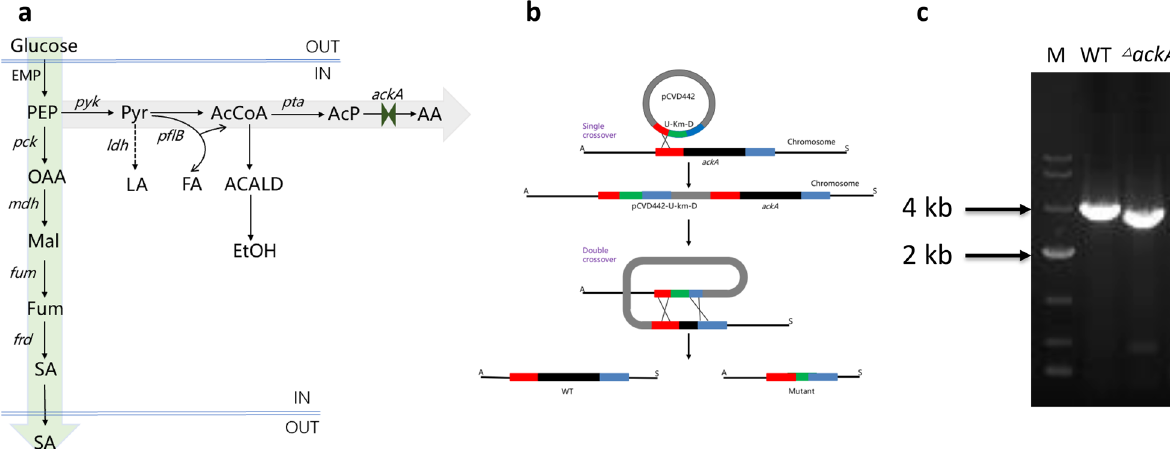
Fig. 1 The central metabolic network for SA biosynthesis in A. succinogenes ( a ) (PEP, Phosphoenolpyruvate; Pyr, Pyruvate; LA, lactic acid; AA, acetic acid; FA, formic acid; ACALD, acetaldehyde; EtOH, Ethanol; OAA, oxaloacetate; Mal, malate; Fum, fumarate; SA, succinic acid; AcCoA, acetyl-CoA; AcP, acetyl-phosphate; pck , phosphoenolpyruvate carboxykinase; mdh , malate dehydrogenase; fum , fumarase; frd , fumarate reductase; pyk , pyruvate kinase; ldh , lactate dehydrogenase; pflB , pyruvate formate-lyase; pta , phosphoacetyltransferase); Schematic diagram of homologous recombination for ackA gene knockout ( b ); PCR analysis of the candidate A. succinogenes colonies (c) (M, 10 kb DNA ladder; WT, 3390 bp; Δ ackA , 3114